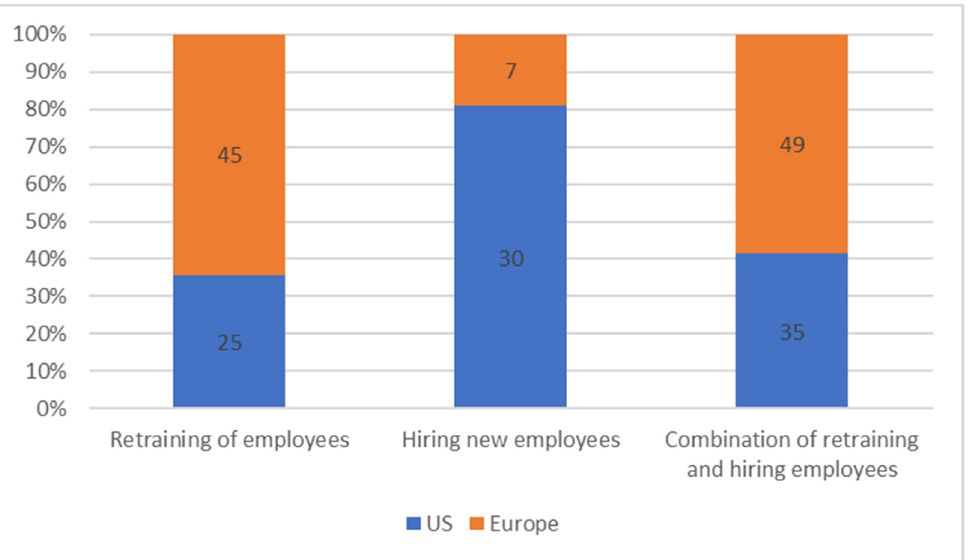
Figure 5. Prospective ways to address the problem of employees lacking skills. Source: the authors based on data from Edwards and Martin (2019).